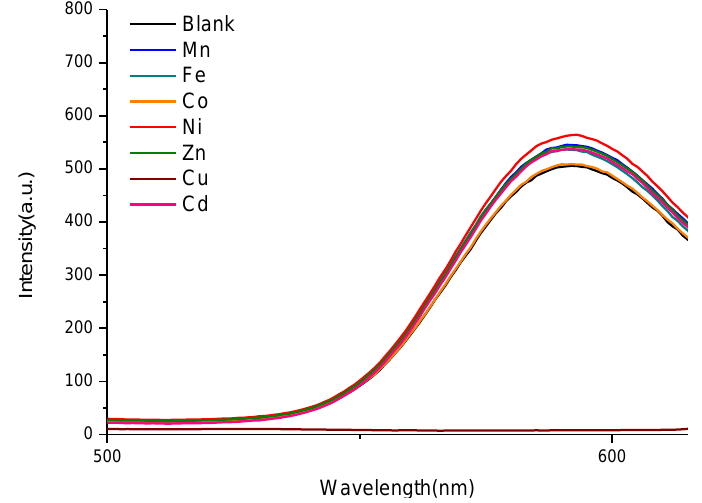
Figure 6. Emission (PL) spectra of the ZnS:Mn-Asp NCs following the addition of divalent transition metal ions. The emission peak of the ZnS:Mn-Asp-Cu (brown) was exclusively diminished. (‘Blank’ refers to no addition of transition metal ions).